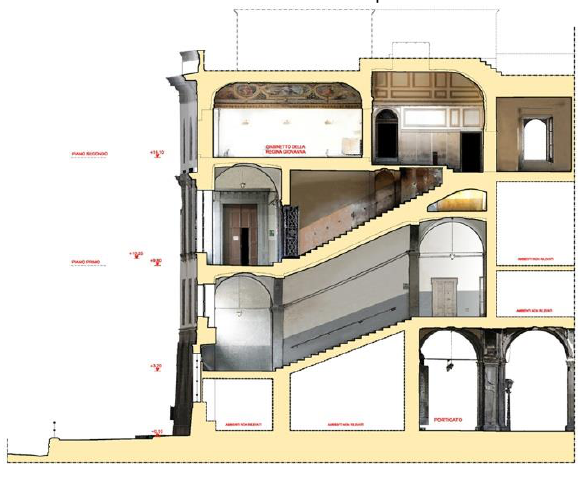
Figure 3. Section of the staircase